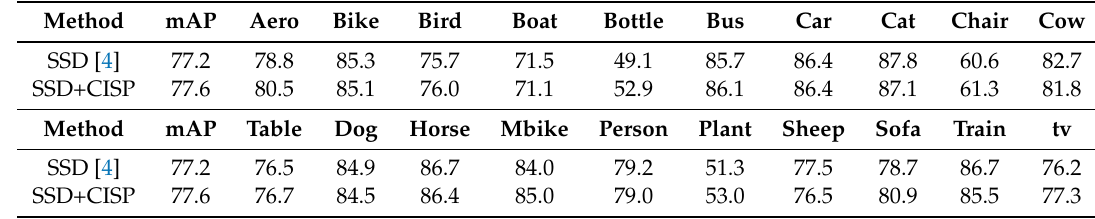
Table 1. Test results of SSD and SSD+CISP.